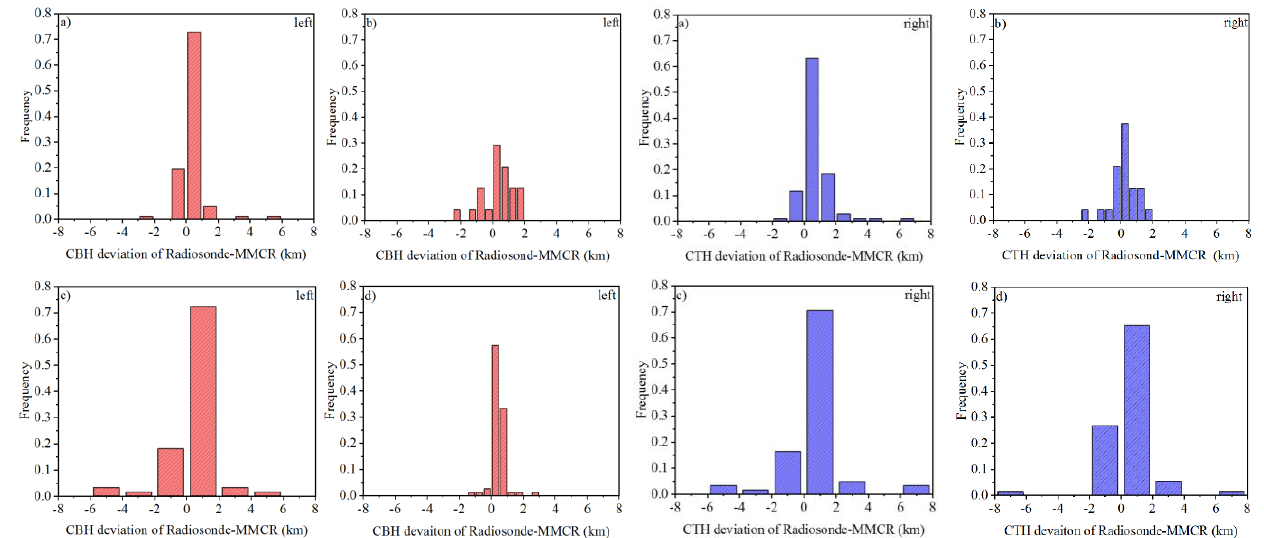
Figure 13. Distributions of the CBH ( left ) and CTH deviations ( right ) detected by the radiosonde and MMCR. ( a ) Spring, ( b ) summer, ( c ) autumn, and ( d ) winter.